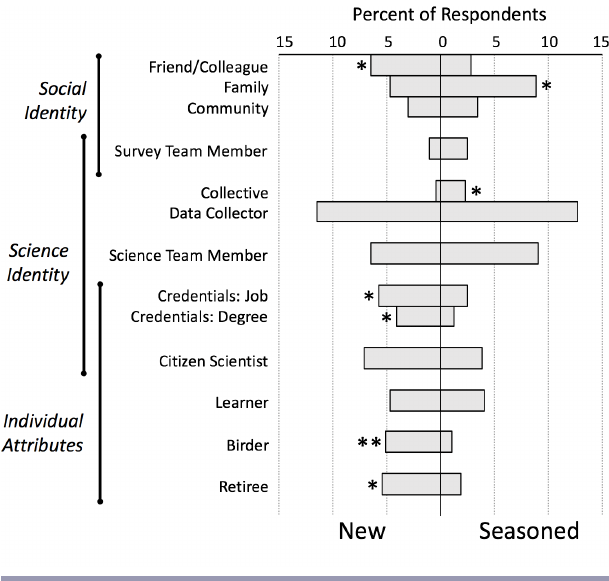
Fig. 4 . Percent of survey respondents expressing senses of self as a function of engagement (new, seasoned). Formatting as in Figure 2. Two-headed lines at left depict three overlapping situational identities with respect to participants in the Coastal Observation and Seabird Survey Team program: social, science, and individual